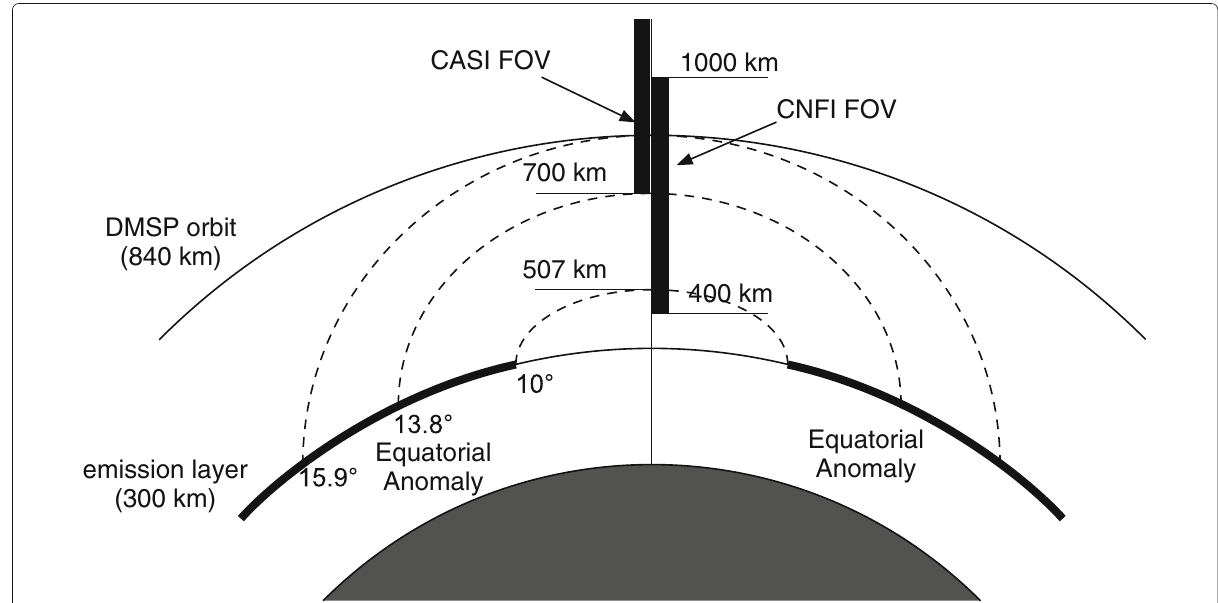
Fig. 7 The altitudes of EIA and FOVs of CASI and CNFI in the equatorial plane and their latitudinal locations mapping along the field